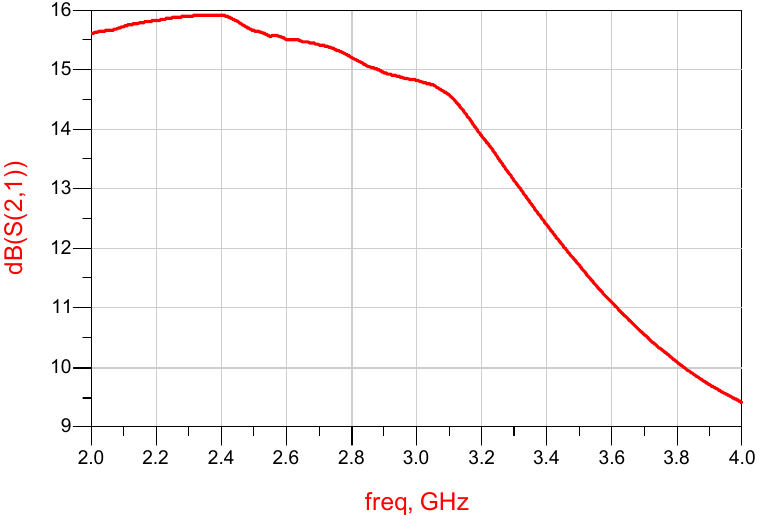
Figure 20. S21 of an Active Stacked Circular Receiving Patch antenna.